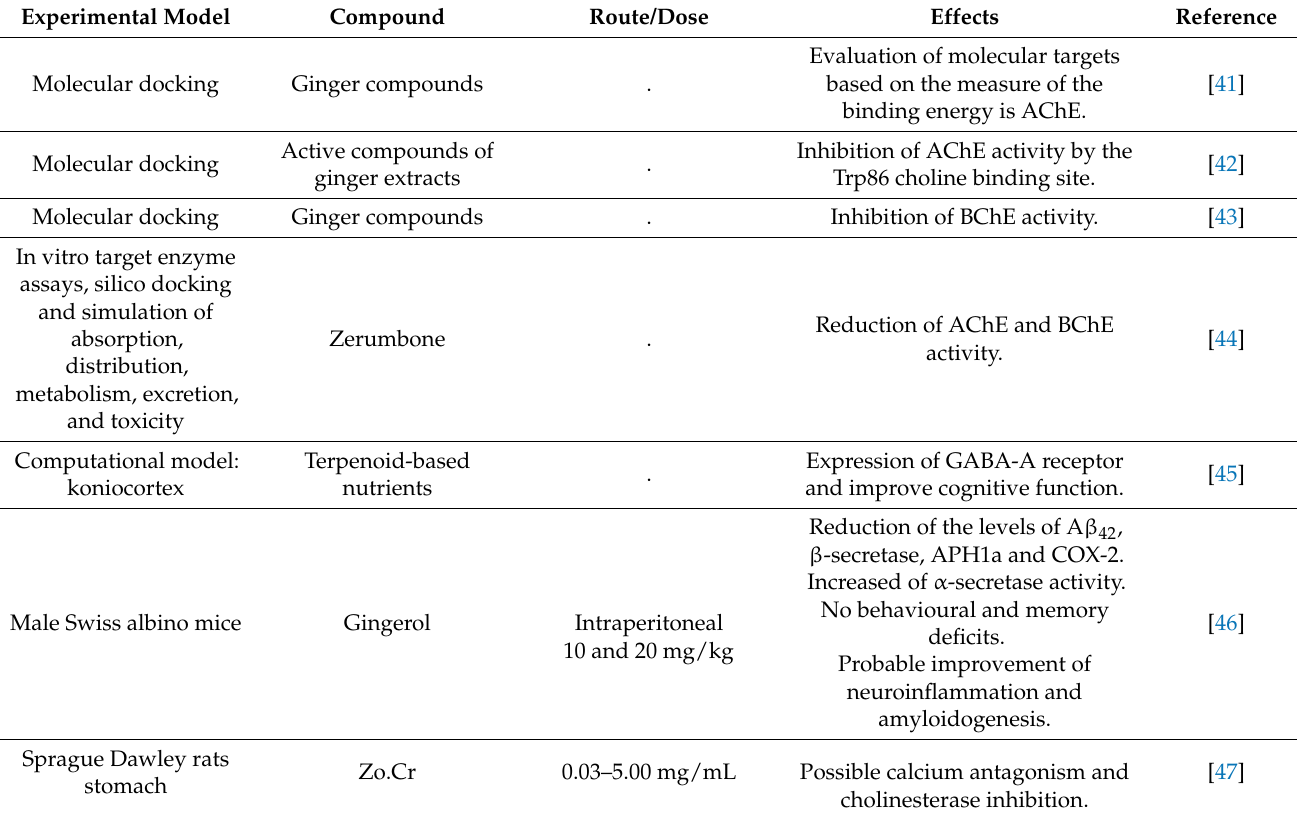
Table 1. Summary of reported studies on ginger effects in AD treatment of prevention. Experimental